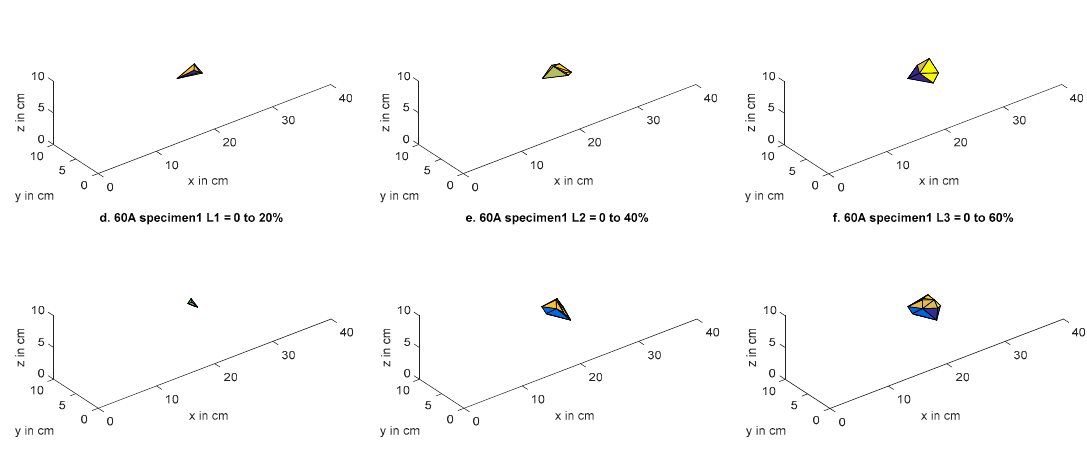
Figure 12. Convex hull volume (CHV) progression seen in space ( x -, y -, and z -axis) for L1, L2, and L3 for specimens WC40A1 ( a – c ), and WC60A1 ( d – f ).